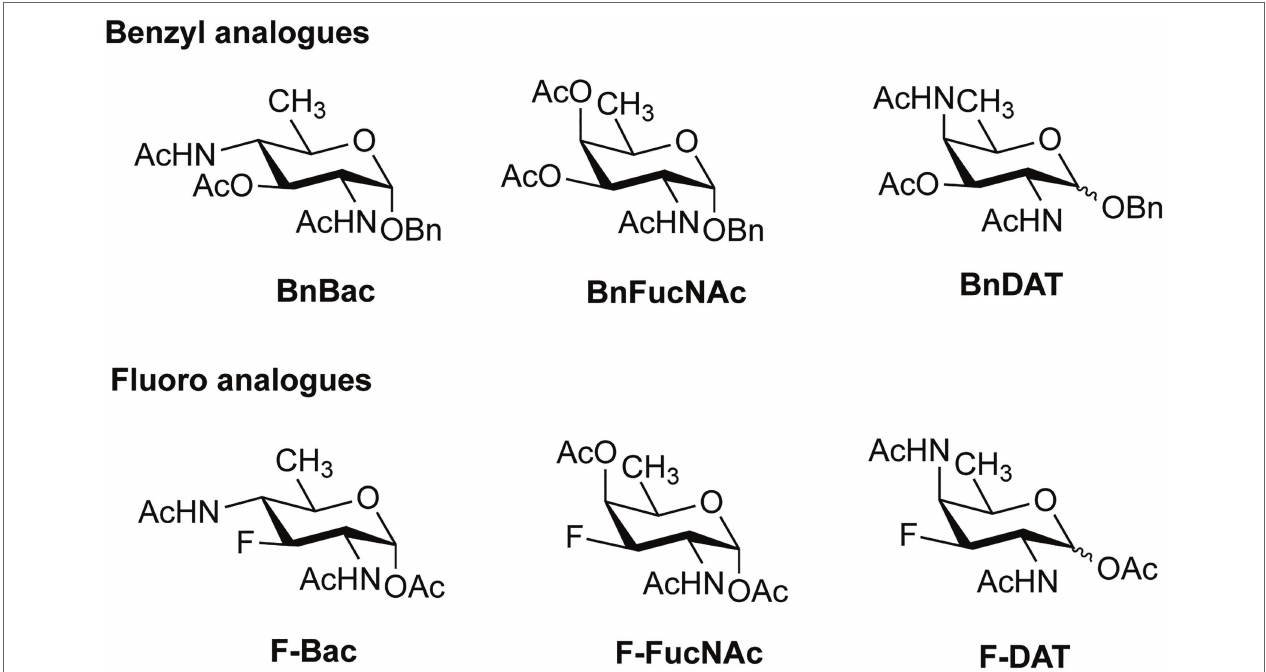
FIGURE 9 | Benzyl and fluoro analogues designed for metabolic inhibition of